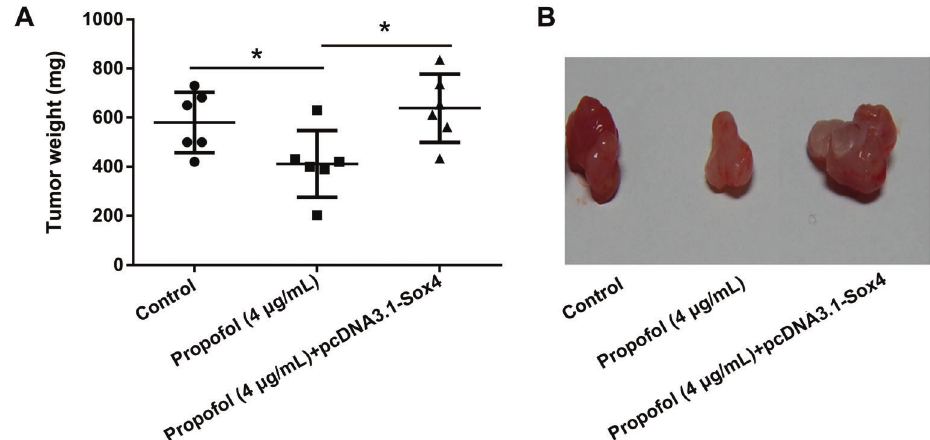
Figure 5. Propofol inhibited tumor formation via regulation of Sox4 in vivo . Human EC Ishikawa cell line was exposed to 4 m g/mL of propofol, and pcDNA3.1-Sox4 was transfected into Ishikawa cells to overexpress Sox4 expression. A , Tumor weight was detected by xenograft tumor model assay. B , Images of tumors obtained from the mice in different treatment groups. EC: endometrial cancer; Sox4: sex-determining region Y-box 4. *P o 0.05 (ANOVA).